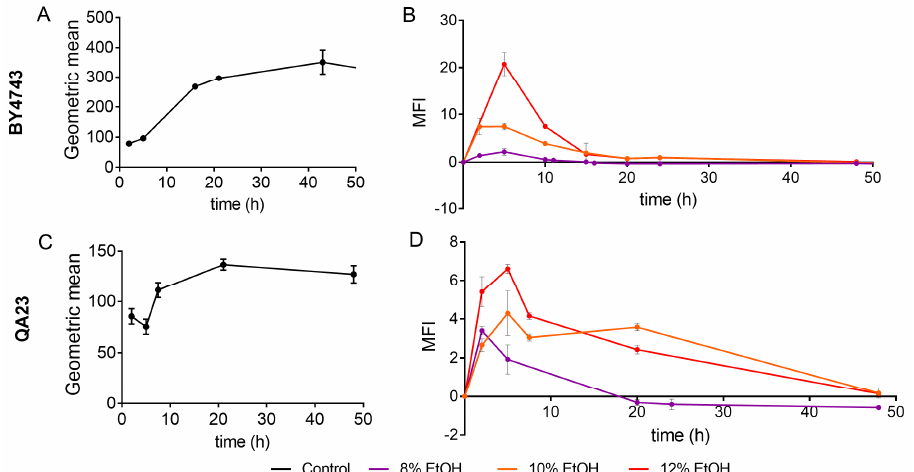
Figure 3. Effect of different ethanol concentrations (0% (black), 8% (purple), 10% (orange), 12% (red))